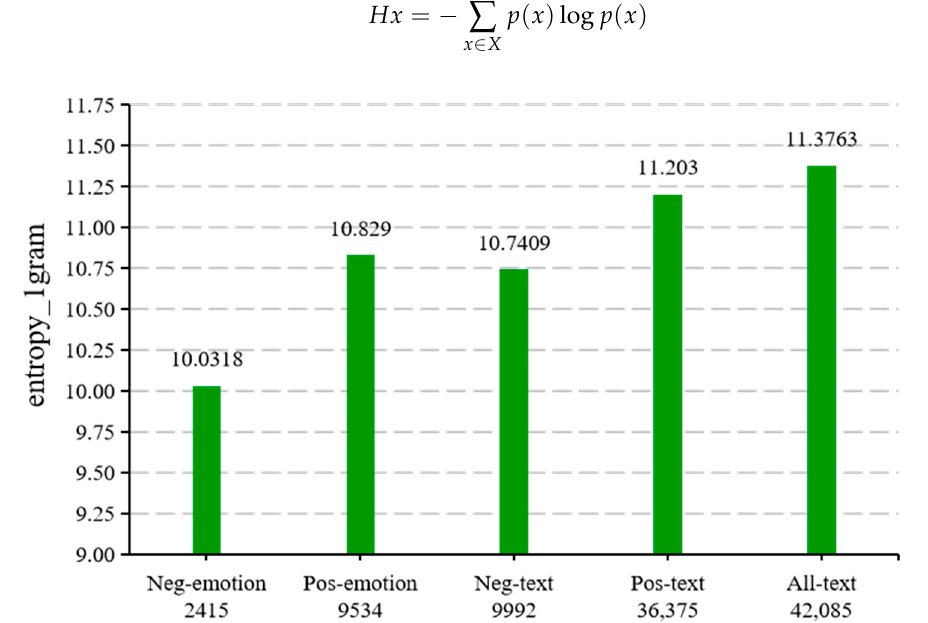
Figure 10. Information entropy of the dataset. The information entropy was calculated using equa-